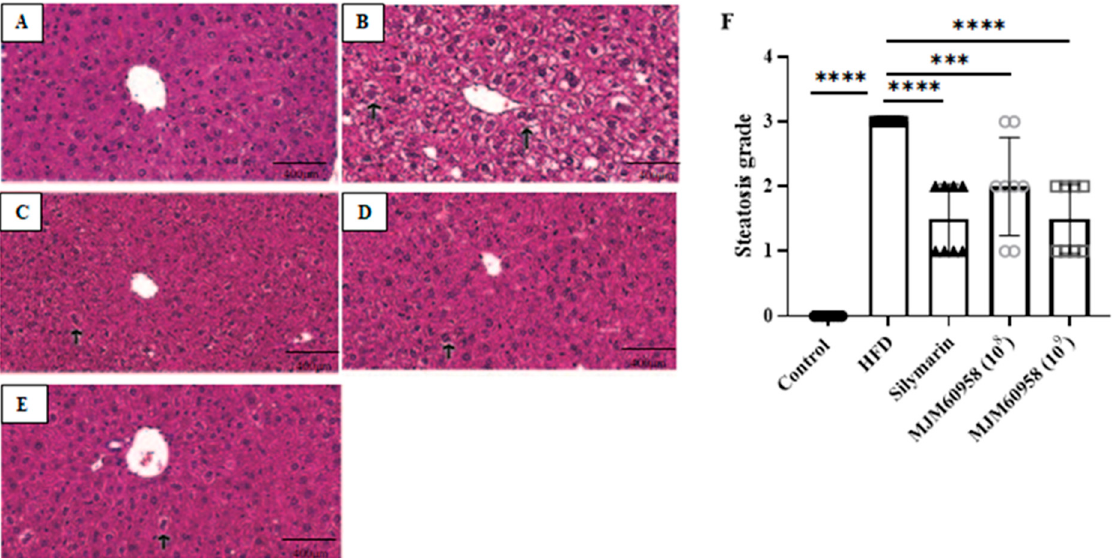
Figure 3. Effect of MJM60958 on histopathology of the liver sections stained with H&E. Black arrow indicates ballooned liver cells. Photographs of HE-stained sections of livers: ( A ) Control, ( B ) HFD ( C ) Silymarin, ( D ) MJM60958 (10 8 ), and ( E ) MJM60958 (10 9 ). ( F ) steatosis grade was quantified based on the percentage of fat vacuolation in hepatocytes: level 0 (healthy, <5%), level 1 (mild, 5–33%), level 2 (moderate, 34–66%), and level 3 (severe, >66%). Data are presented as the mean ± SD ( n = 8), *** p < 0.001, **** p < 0.0001 compared with HFD group. Scale bar: 400 μ m. (Magnification, 400×).